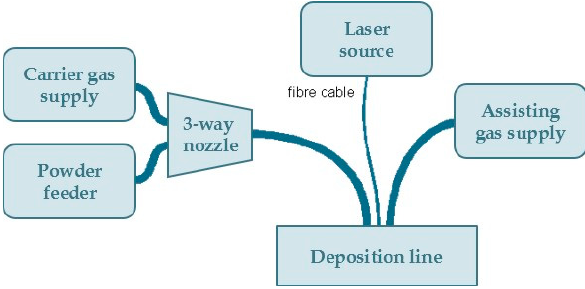
Figure 1. Main components in the laser deposition line.